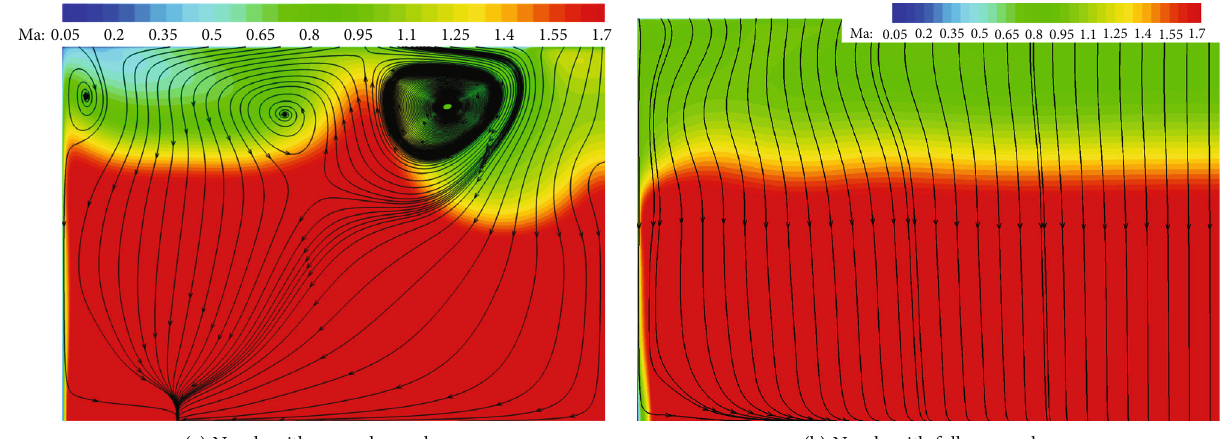
Figure 14: Vortex structure of monitoring surface d.